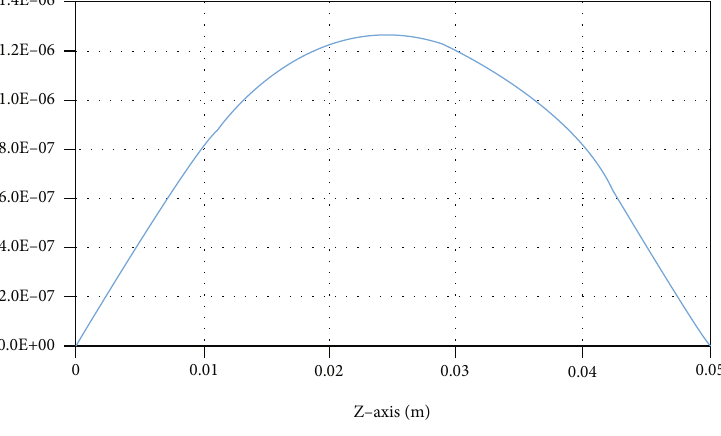
(b) Spatial distribution of displacement of the prototype on the red line Figure 8: Spatial distributions of displacement of the prototype and the